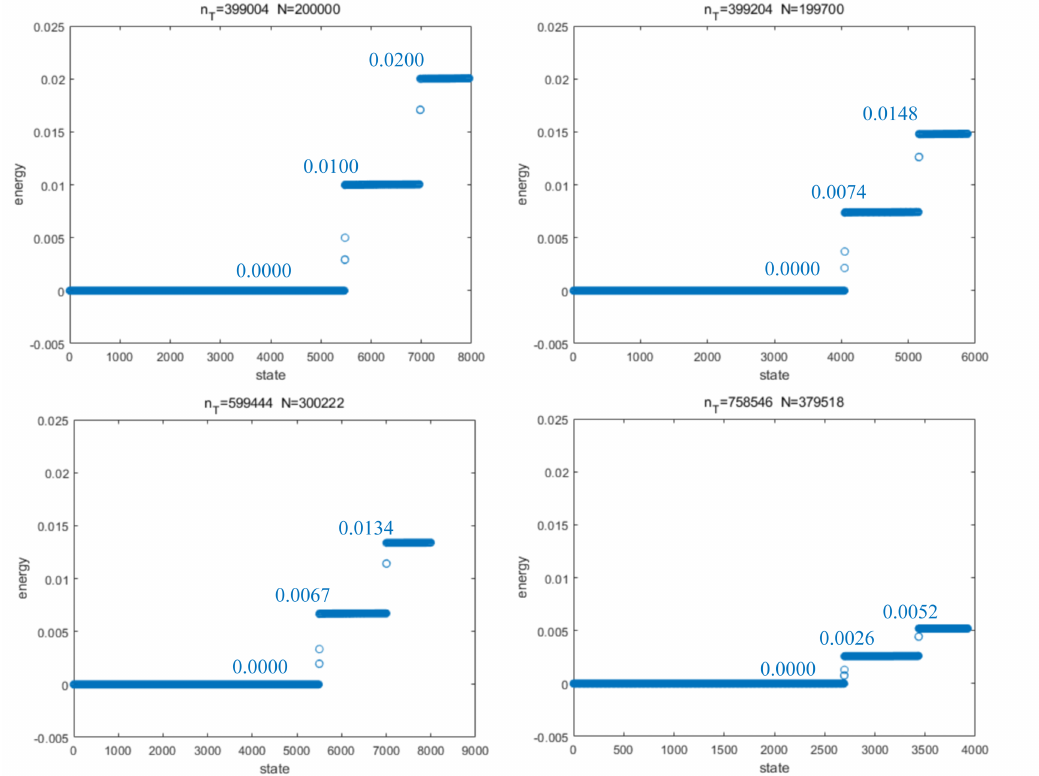
Figure 3 . The parameters n T and N of the system are shown above each spectrum. It is easy to verify that the intervals between adjacent energy levels are constant in each